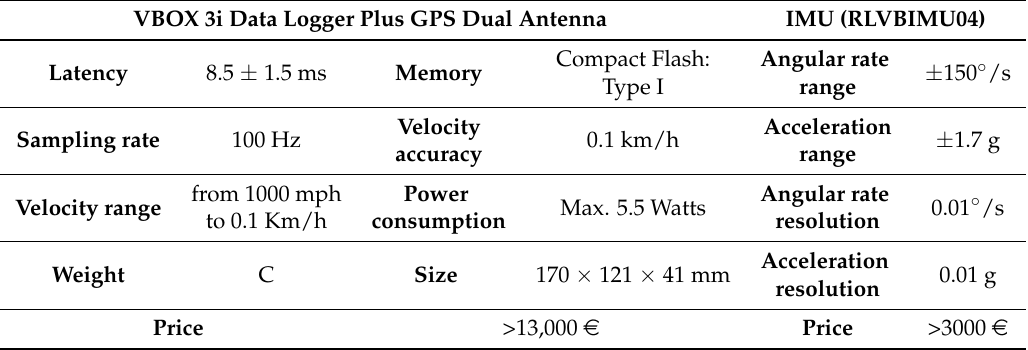
Table 1. Technical specifications of hardware elements included in the VBOX kit (ground truth).